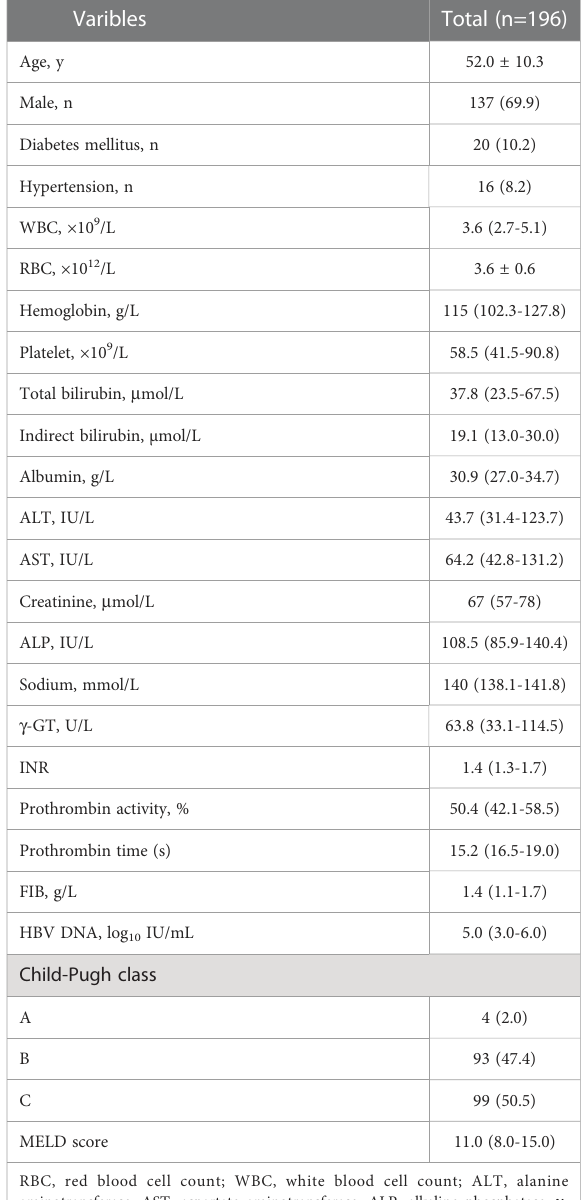
TABLE 1 Baseline characteristics of the patients in the total